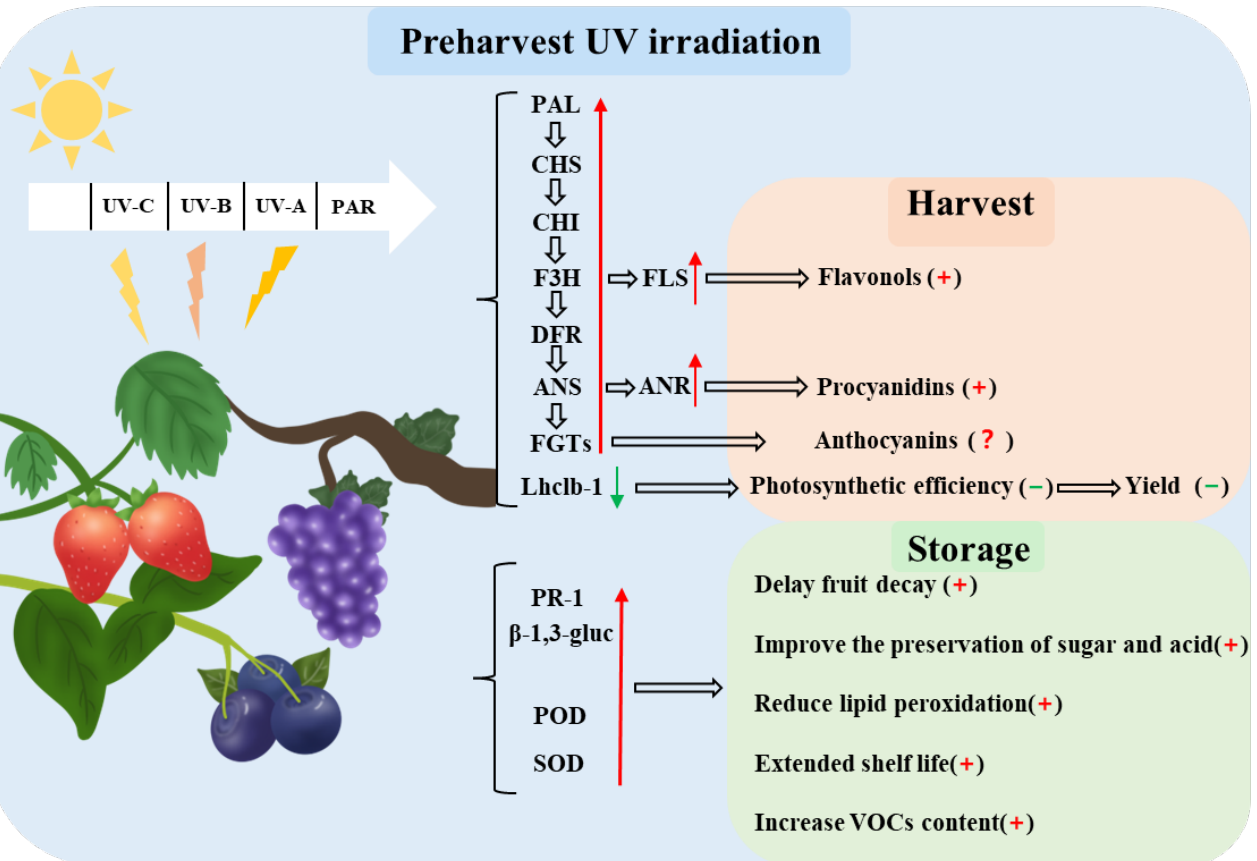
Figure 1. Effect of preharvest UV irradiation on berries. ANS: anthocyanidin synthase; CHI: chalcone isomerase; CHS: chalcone synthase; DFR: dihydroflavonol 4-reductase; F3H: flavanone 3ß-hydroxylase; FGTs: flavonoid glycosyltransferases; FLS: flavonol synthase; PAL: phenylalanine ammonia-lyase; POD: Peroxidase; PR-1: pathogenesis-related protein 1; SOD: Superoxide Dismutase; β -1,3- gluc: β -1,3-glucanase.